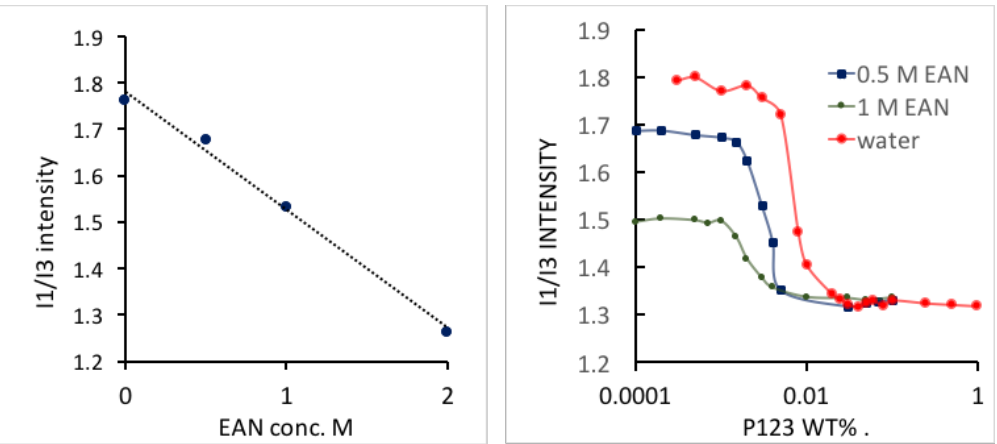
Figure 8. ( Left ) Pyrene fluorescence emission I 1 / I 3 intensity ratio of EAN aqueous solutions; ( right ) pyrene fluorescence emission intensity I 1 / I 3 ratio plotted against Pluronic P123 block copolymer concentration in aqueous solutions having different concentration of EAN.